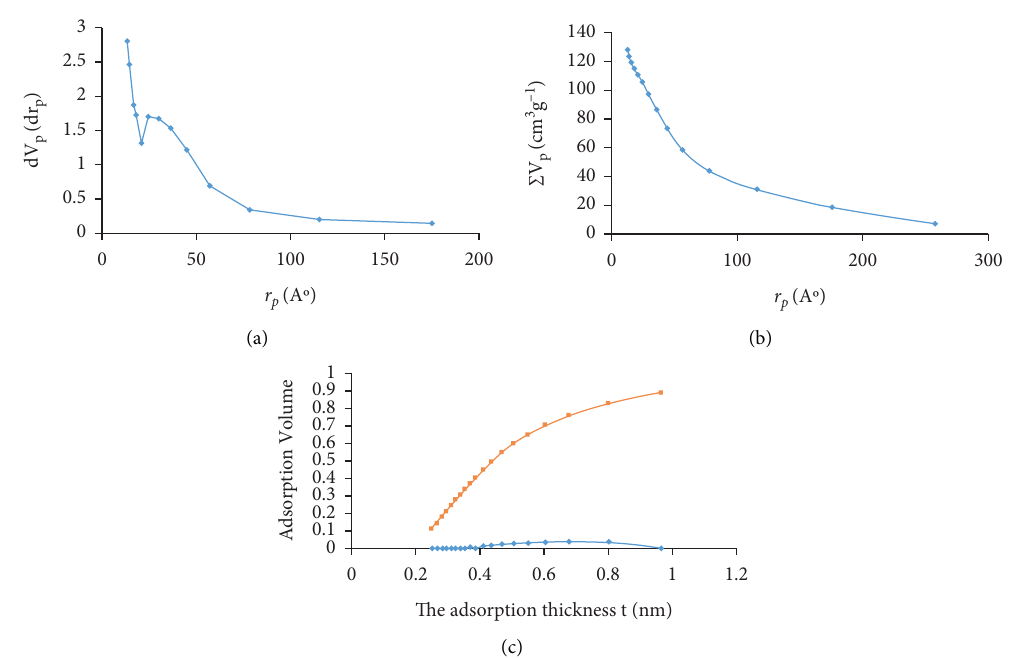
Figure 7: (a) dBJH plot, (b) BJH plot, and (c) MP plot